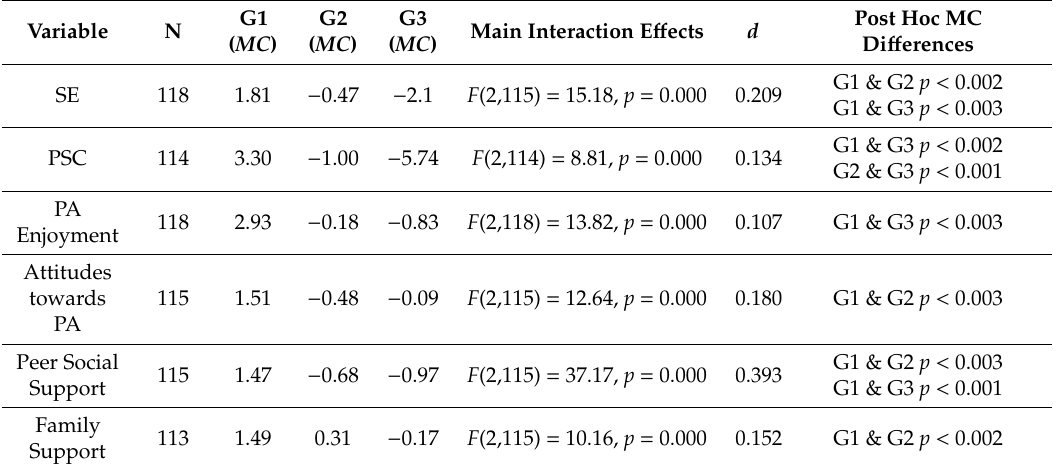
Table 3. Mean change (MC) di ff erences and significant interaction e ff ects (within time and between-group) for the psychological